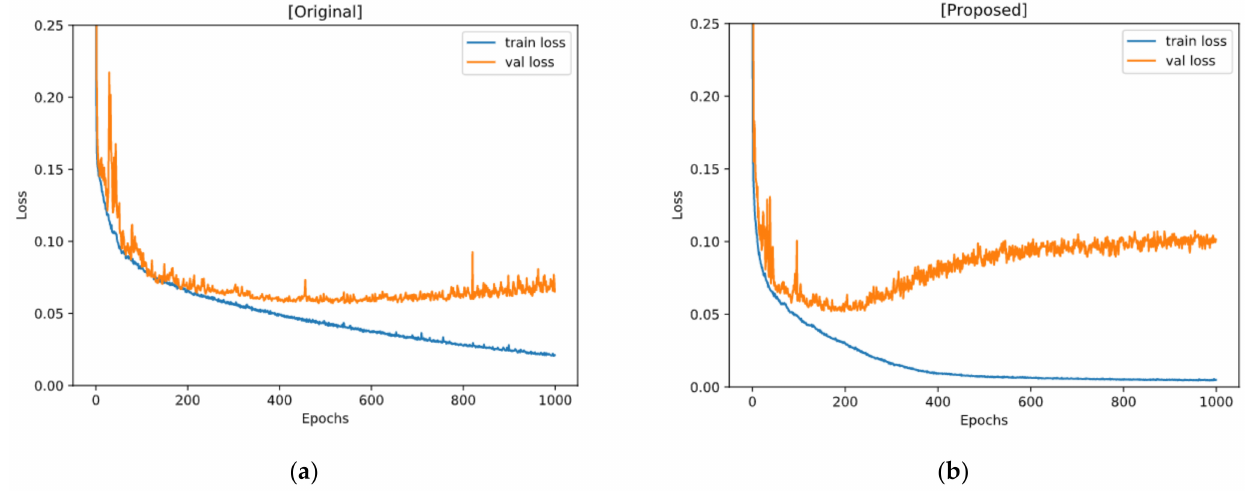
Figure 15. Training/validation loss for the ( a ) original and the ( b ) proposed method